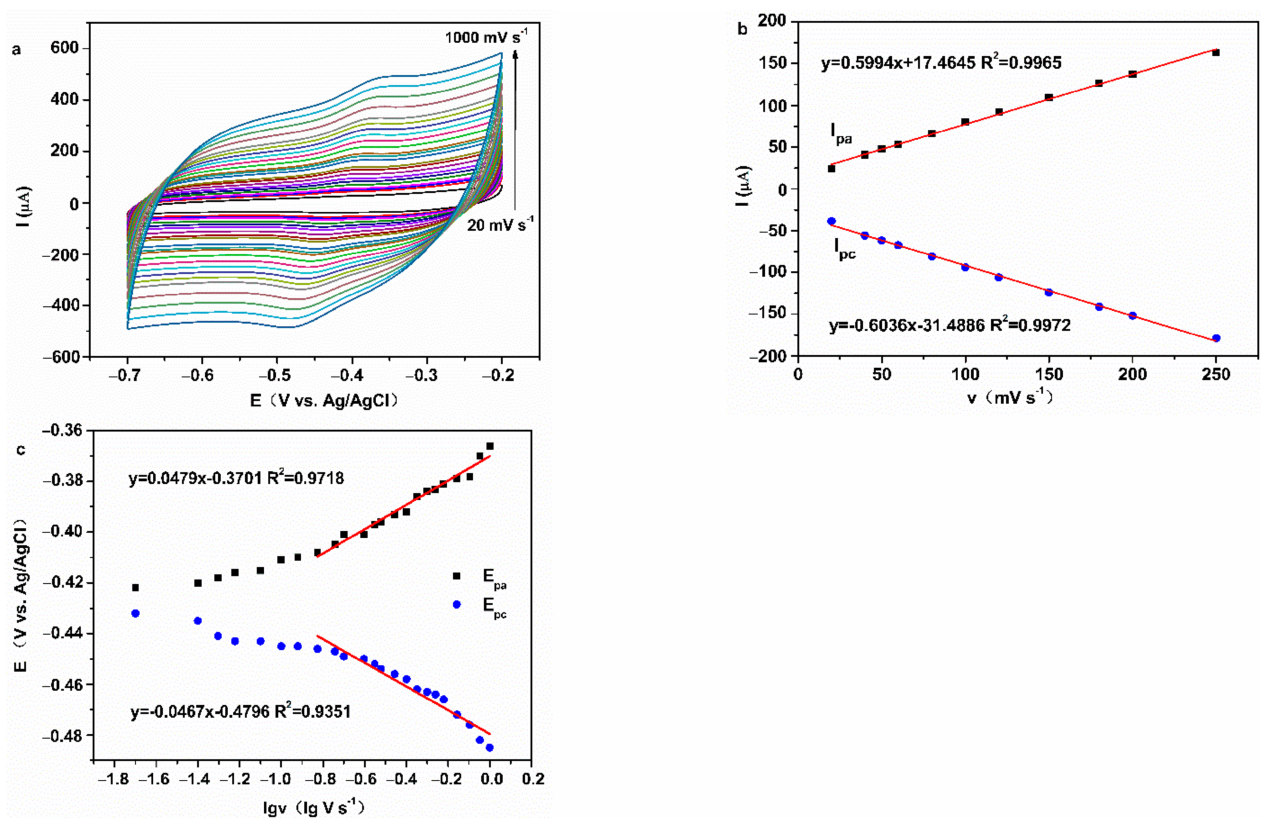
Figure 8. The CV curves of Nafion/GOD/FeOOH-GA 0.25 /GCE at various scan speed ( a ), polt of I pa and I pc vs. v for Nafion/GOD/FeOOH-GA 0.25 /GCE ( b ), polt of E pa and E pc vs. lgv for Nafion/GOD/FeOOH-GA 0.25 /GCE ( c